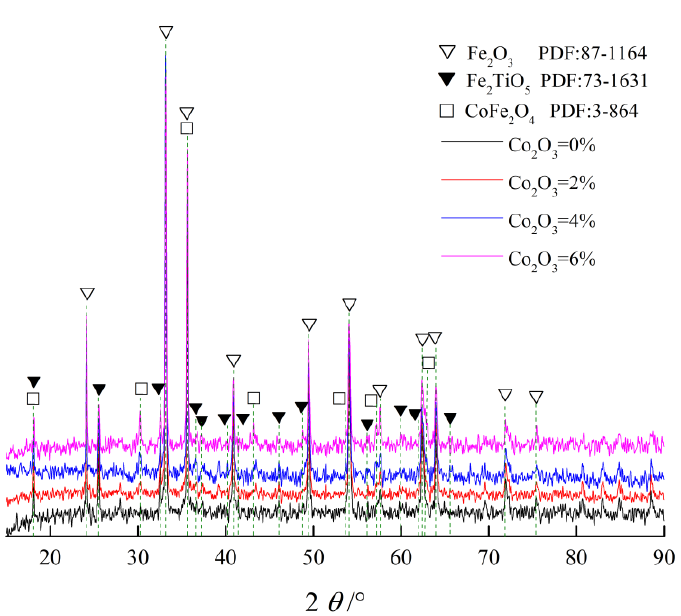
Figure 4. XRD patterns of CVTP with Co 2 O 3 additions.